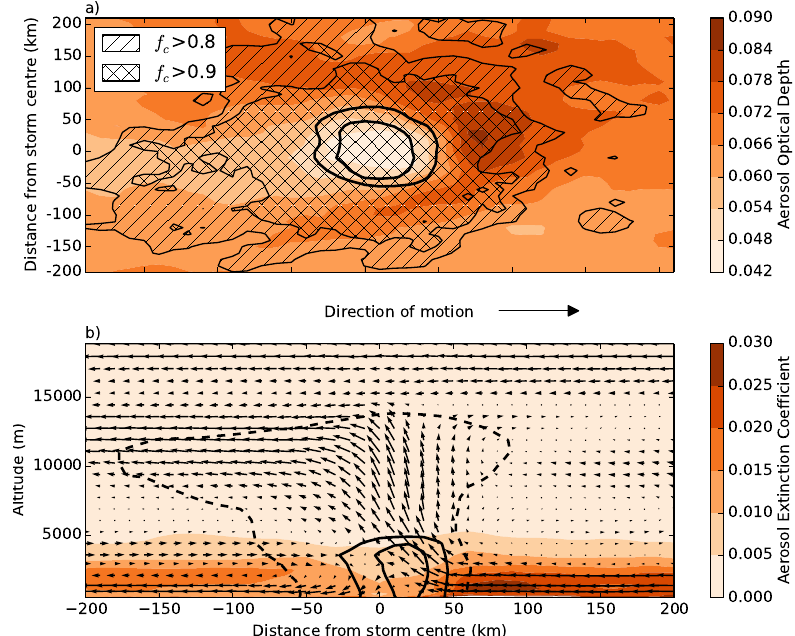
Figure 5. A composite of storms from a 3-week WRF-Chem simulation in March 2007 over the Congo Basin. The storm composite is moving from left to right on the above plots. (a) A horizontal plot with the orange filled contours showing the integrated aerosol optical depth and the hatched regions showing cloud-covered regions in 80 and 90% of the storms making up the composite. The solid lines are the 2 and 5mmh − 1 rain-rate contours. (b) A vertical cross section through the centre of the composite storm. The orange contours show the aerosol extinction coefficient and the arrows indicate the wind direction relative to motion of the storm centroid. The vertical wind has been enhanced by a factor of five to compensate for the different vertical and horizontal scales. The solid contours show the 0.2 and 0.8gkg − 1 levels of rainwater content and the dashed contour is the − 20dbZ radar reflectivity